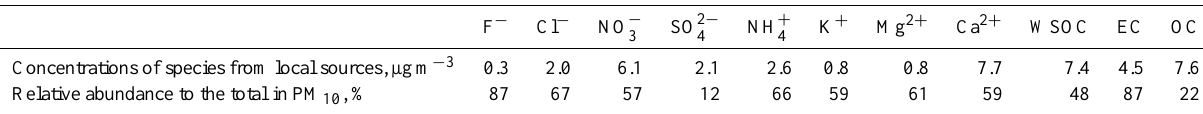
Table 2. Concentrations of species derived from local sources and their relative abundance to the total in PM 10 samples of Xi’an during the dust storm event (DS II, 24 April 2009).